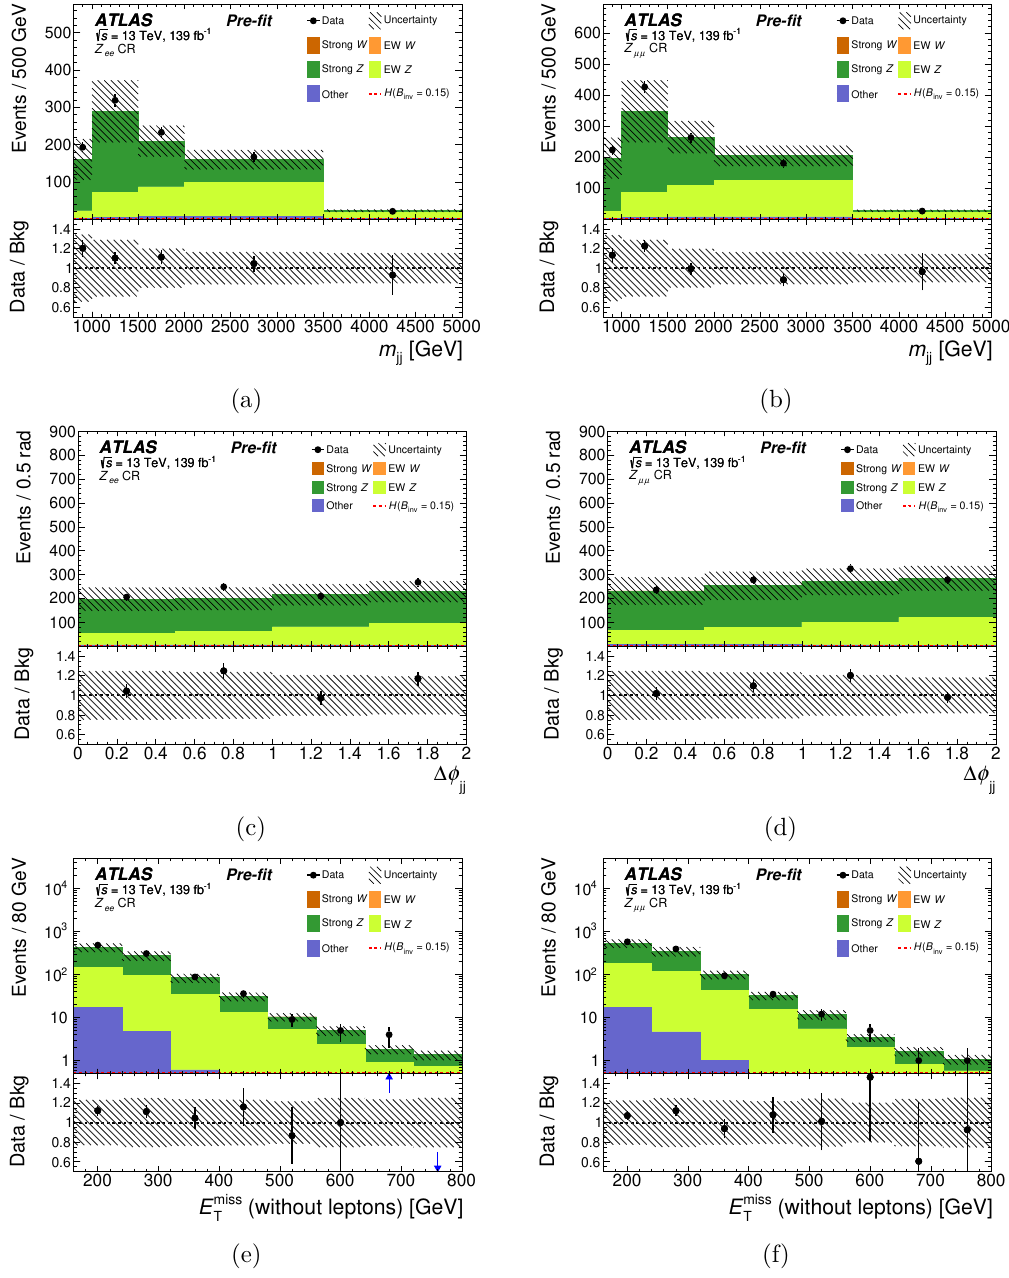
(without leptons) in the Figure 3. Observed and predicted distributions of m jj , ∆ φ jj , and E miss T Z ‘‘ control regions, separately for Z → e + e − ((a), (c), and (e)) and Z → µ + µ − ((b), (d), and (f)). The MC predictions are normalised to cross sections times luminosity and are shown prior to the likelihood fit. Minor contributions from t ¯ t , V V , V V V , and VBF H with H → τ + τ − or H → W ∗ W are combined and labelled ‘other’. The tiny contributions from W + jets processes are not visible for the given value range. The hatched band indicates statistical and experimental systematic uncertainties. The dielectron and dimuon channels are combined to a dilepton CR in the statistical